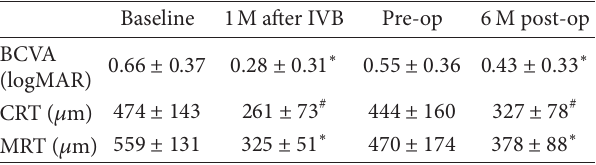
Table 1: Summary of BCVA, CRT, and MRT in the study